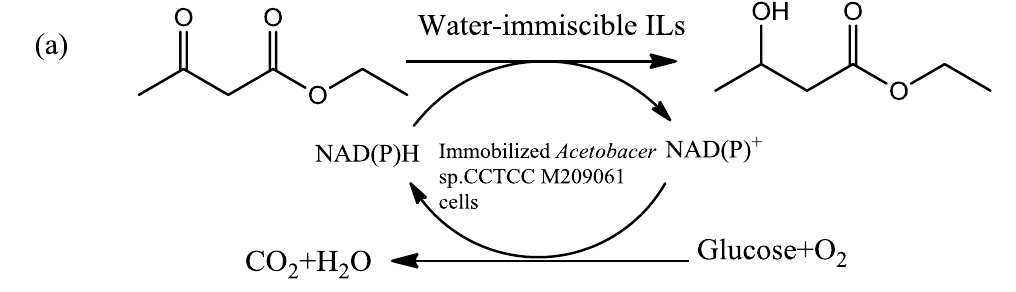
Figure 2. Examples of biotransformation from microorganism cells with ILs. ( a ) The asymmetric reduction of ethyl acetoacetate (EAA) catalyzed by immobilized Acetobacter sp. CCTCC M209061 cells; ( b ) The bioreduction of 4-(trimethylsilyl)-3-butyn-2-one (TMSB) to ( S )-4-(trimethylsilyl)-3-butyn-2-ol ( S )-TMSBOL with immobilized Candida parapsilosis CCTCC M203011 cells in water-immiscible IL/buffer biphasic systems; ( c ) The biocatalytic asymmetric reduction of 4'-methoxyacetophenone (MOAP) catalyzed by Rhodotorula sp. AS2.2241 cells; ( d ) Asymmetric reduction of ketone and recycling of coenzyme catalyzed by Geotrichum candidum dried cell containing alcohol